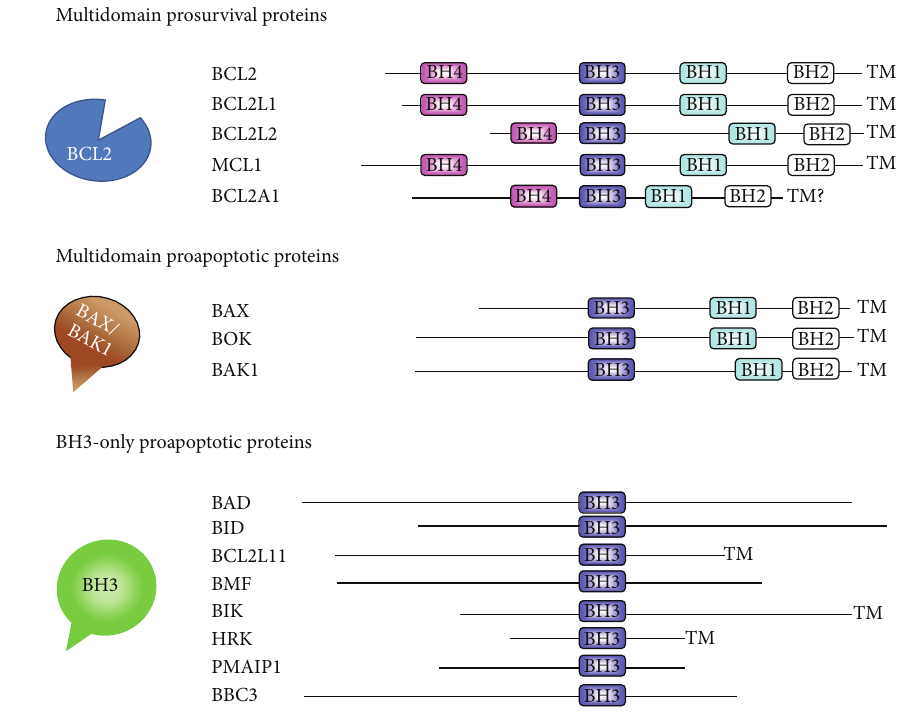
Figure 2: Classification of the BCL2 family into three subfamilies of BCL2-related proteins. The four BCL2 homology (BH) domains are the mosthighlyconservedamongBCL2family.Theprosurvivalproteinscontainfour 𝛼 -helixBHdomains(BH1-4).BH1-3domainsofprosurvival proteins form a hydrophobic cleft that binds proapoptotic proteins through their hydrophobic BH3 domains.The multidomain proapoptotic proteins have BH1-3 domains, while the proapoptotic BH3-only proteins share only the BH3 domain with the other BCL2-related proteins. Most members have a carboxy-terminal hydrophobic transmembrane (TM) domain, with the exceptions of many of the BH3-only proteins and probably